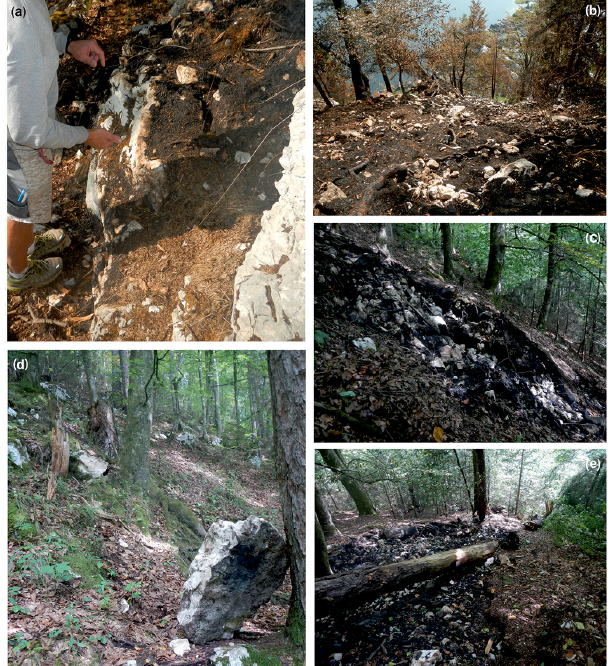
Figure 2. Indication of wildfire severity. (a) Crack development in the scree. (b) Ash and needles cover the terrain with a “sealing ef- fect” reducing the infiltration capacity. (c) Talus slope beneath the rock wall is covered by a thin soil layer. (d) Rockfall boulders de- tached during the wildfire are often easily identifiable by their black colour. (e) The protection forest beneath the rock wall only was af- fected to a very minor extent due to the anabatic winds and high moisture of the brown rendzina and brown earth.